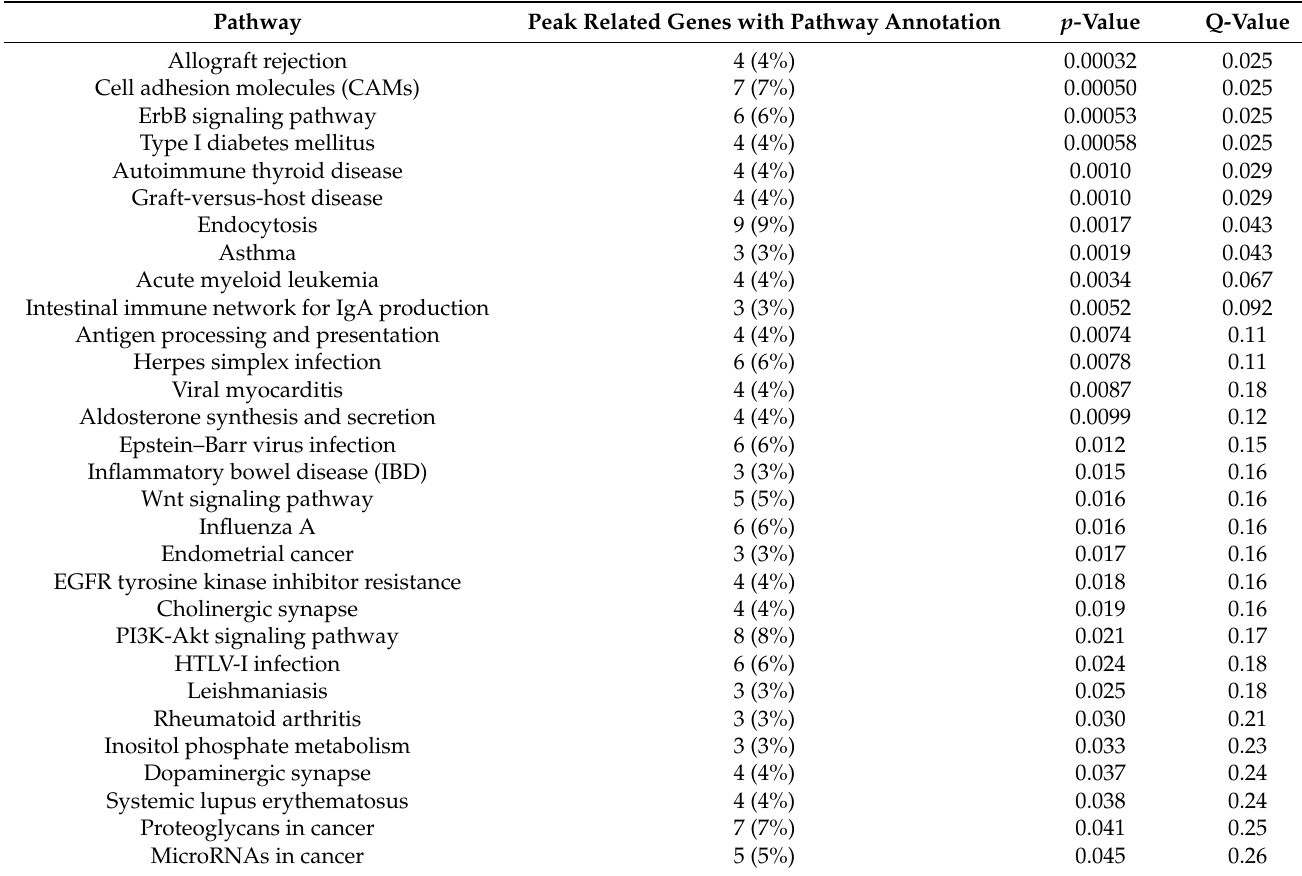
Table 5. Functional pathways related to T2D-specific H3K9ac enrichment changes. Pathway Peak Related Genes with Pathway